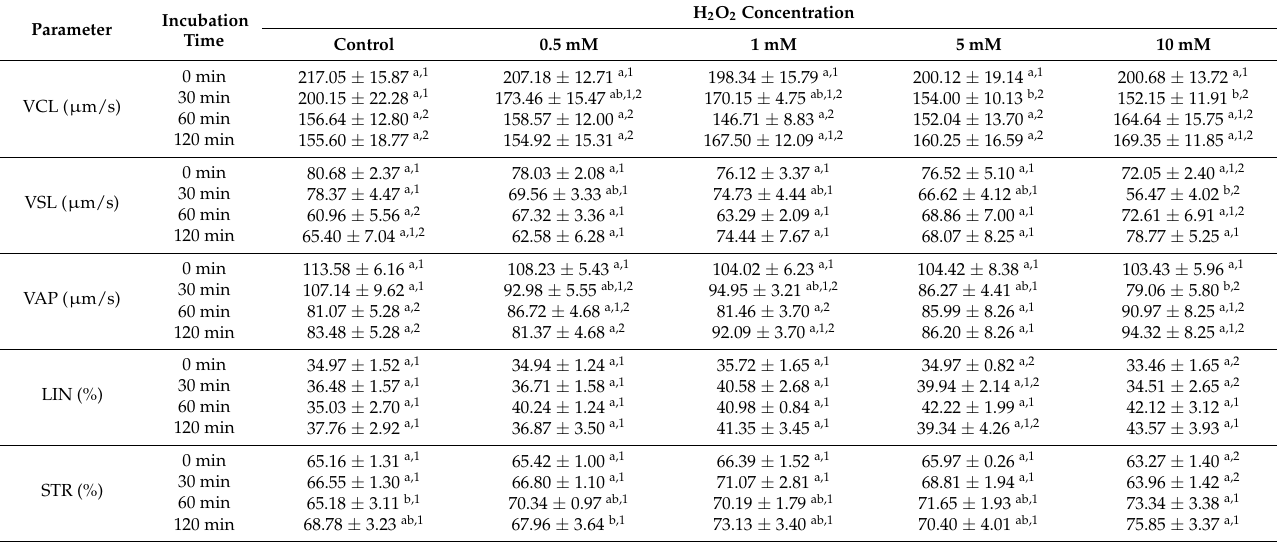
Table 2. Mean ± SEM of the kinematic parameters of donkey sperm exposed to oxidative stress with different hydrogen peroxide (H 2 O 2 ) concentrations measured at different incubation